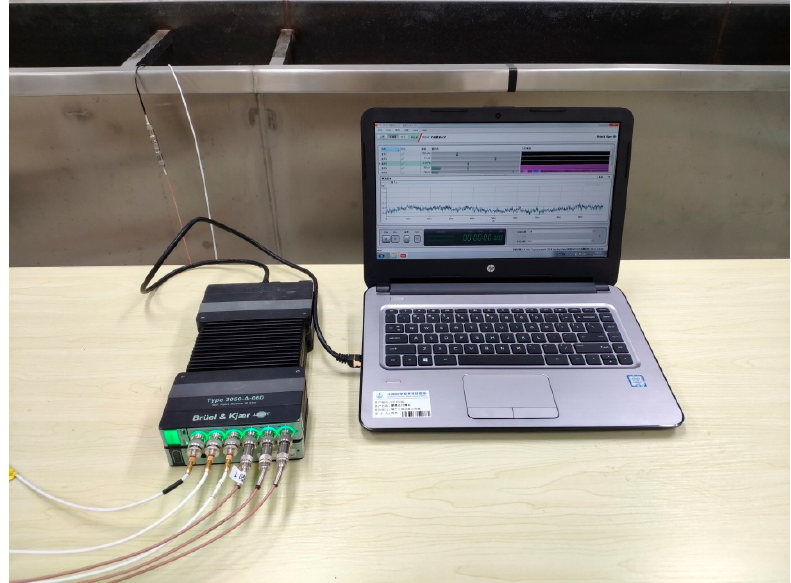
Figure 6. Data acquisition system.